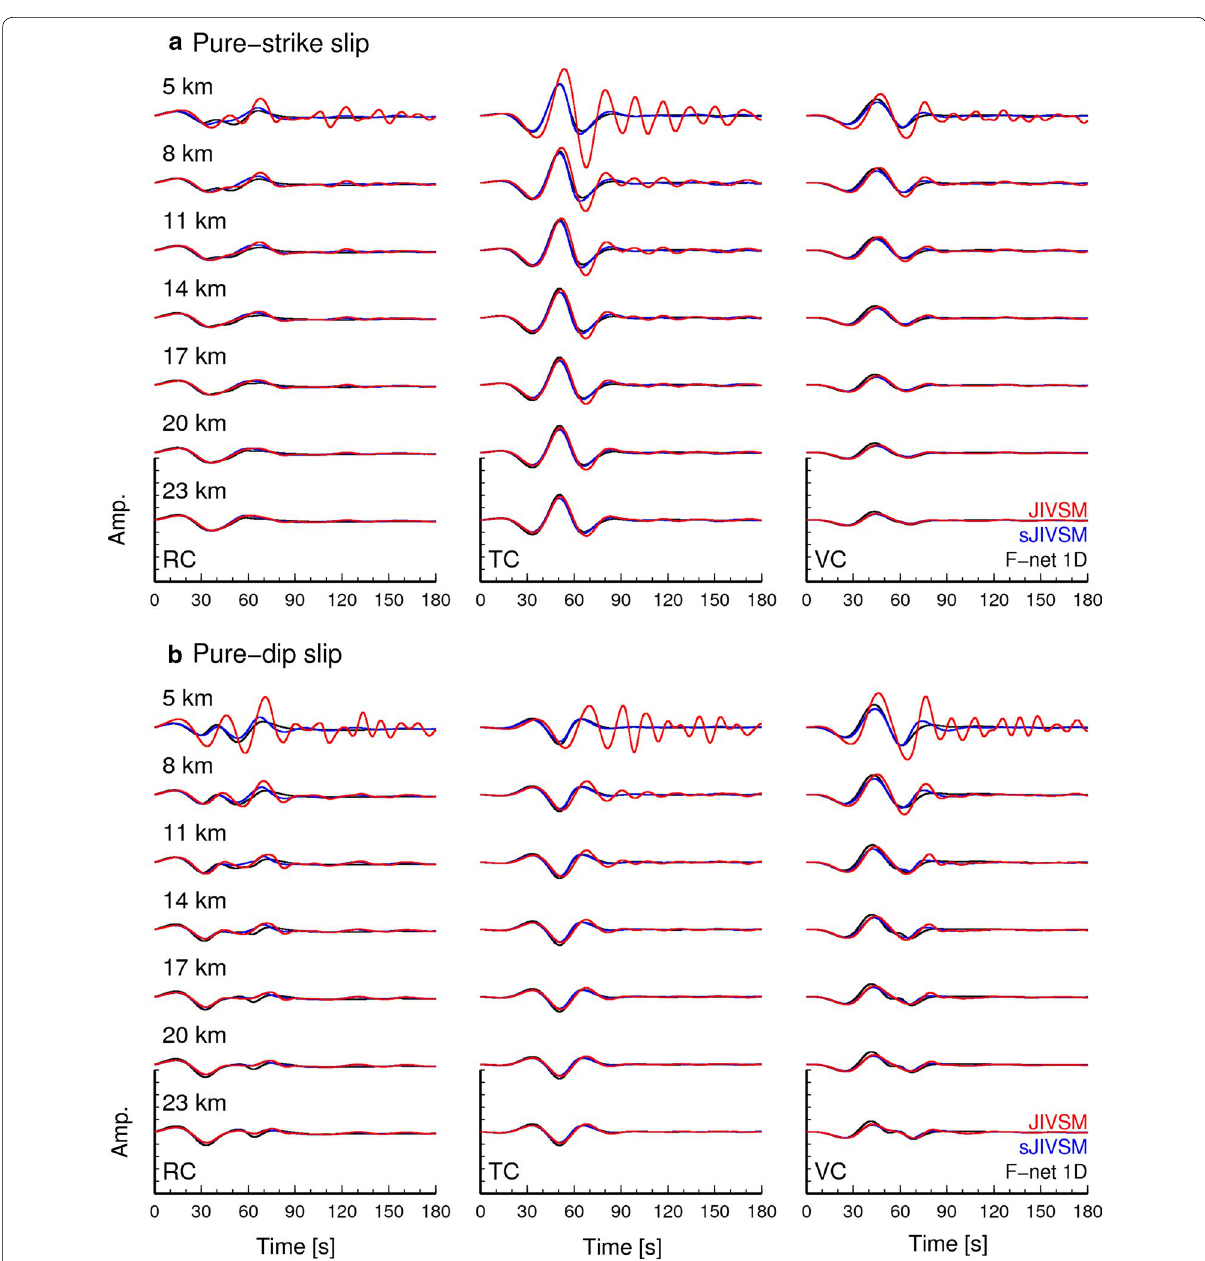
Fig. 4 Depth variation of Green’s functions for pure strike- and pure dip slip moment tensors. Three-component displacement waveforms for the a pure strike-slip ( M xy 1.0) and b pure dip slip ( M zz M xx 1.0) sources. A band-pass filter with passed periods of 30–100 s was applied into each = = − = trace recorded at F-net station N.ABUF. Red, blue, and black traces are Green’s functions derived from the JIVSM (Koketsu et al. 2012), sJIVSM (JIVSM without an accretionary prism and seawater), and F-net 1D velocity structure model (Kubo et al. 2002),